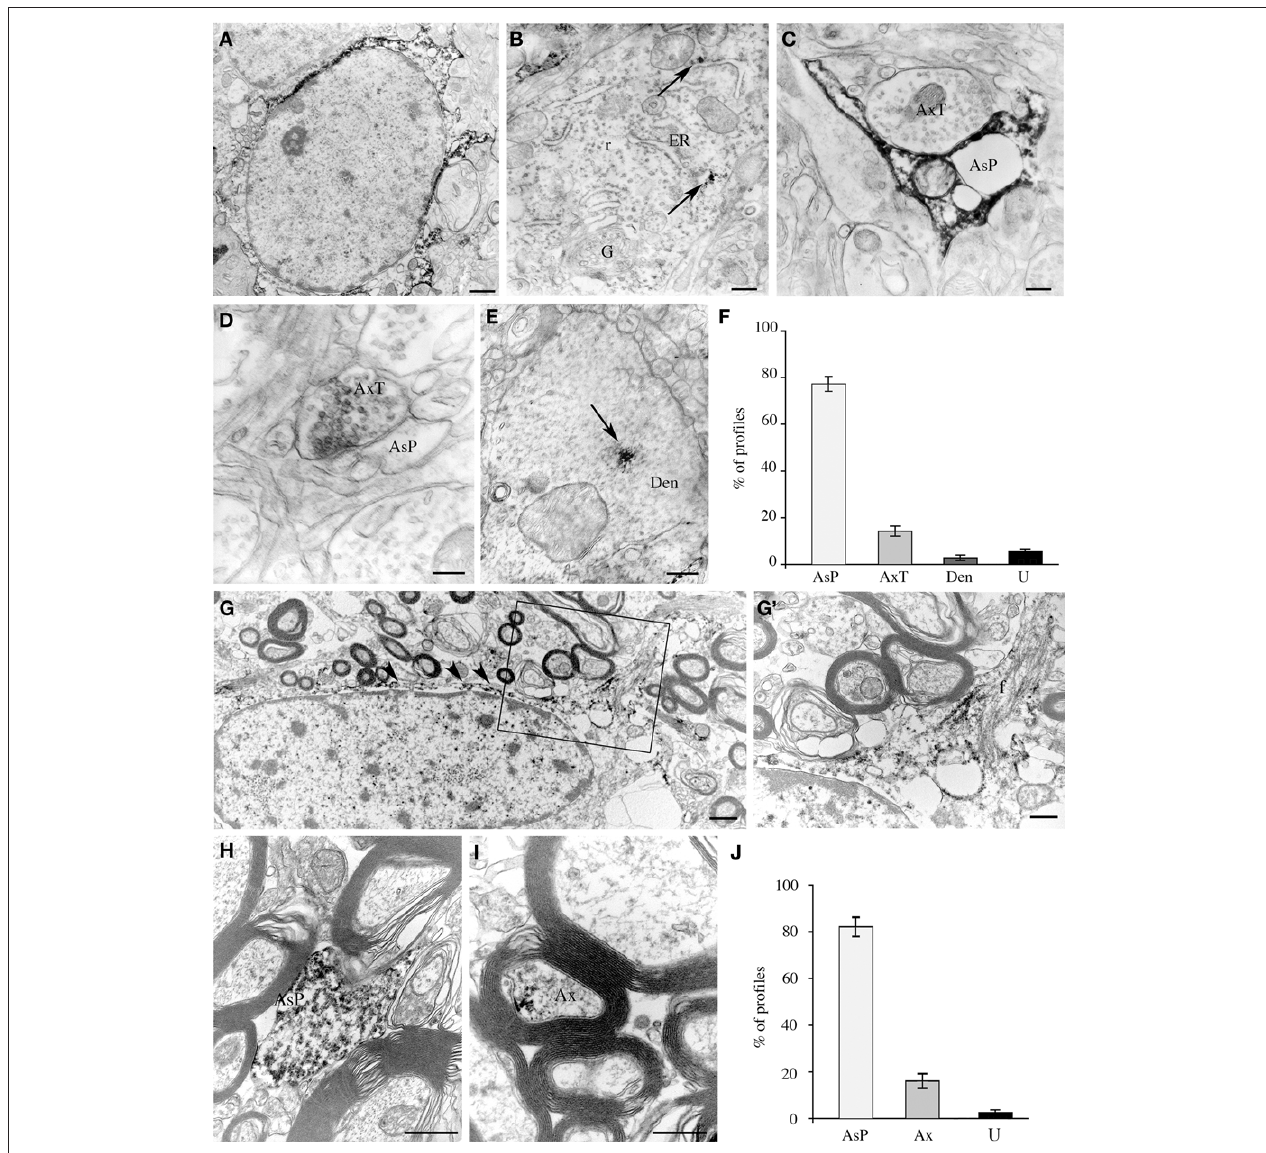
FiGurE 5 | Cellular localization of EAAT2a-ir in human cerebral cortex studied by pre-embedding electron microscopy. (A–E) In gray matter, EAAT2 ir is localized to astrocytes (A) and rarely in neurons (B) , where it is closely associate to endoplasmic reticulum (arrows). In the neuropil, EAAT2a is observed in astrocytic processes (C) , axon terminals (D) , and dendrites (E) . Area 10; case HBC 980611. (F) Quantification of EAAT2a + profiles in gray matter. (G–i) In white matter, EAAT2 ir is in fibrous astrocytes [arrowheads in